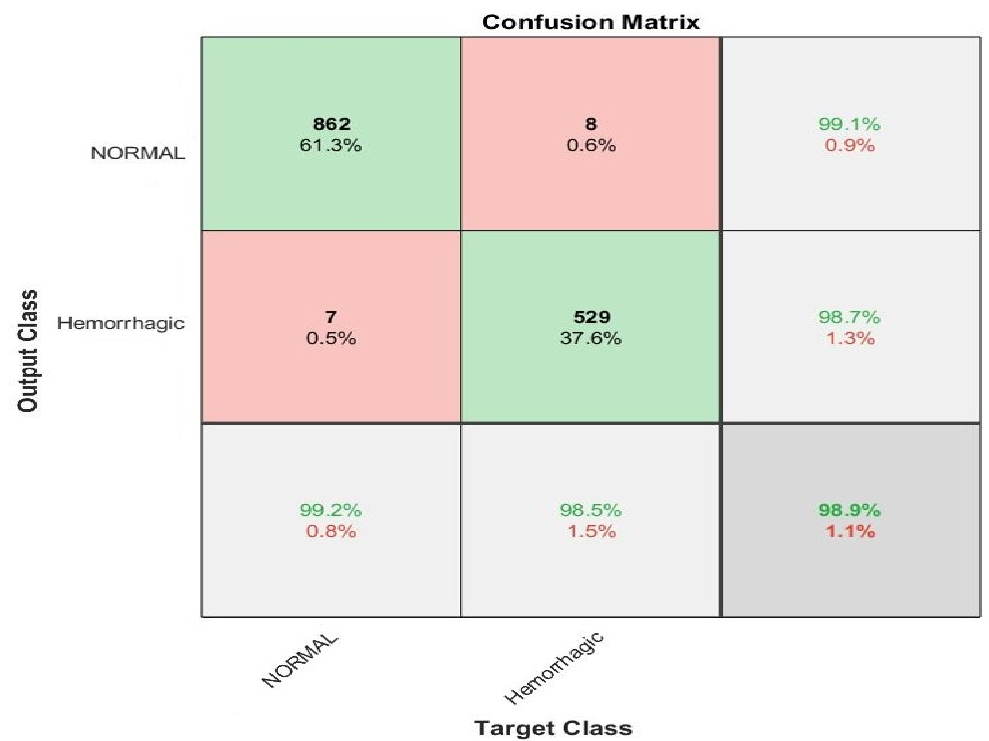
Figure 19. ANN’s confusion matrix based on features fused between GoogLeNet and GLCM and